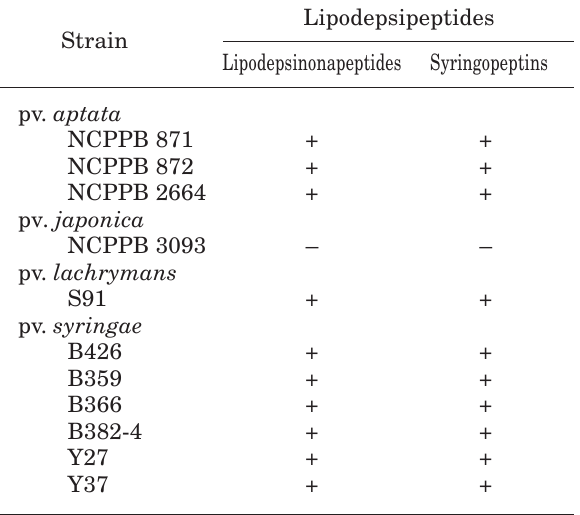
Table 5. Lipodepsipeptide production by four pathovars of Pseudomonas